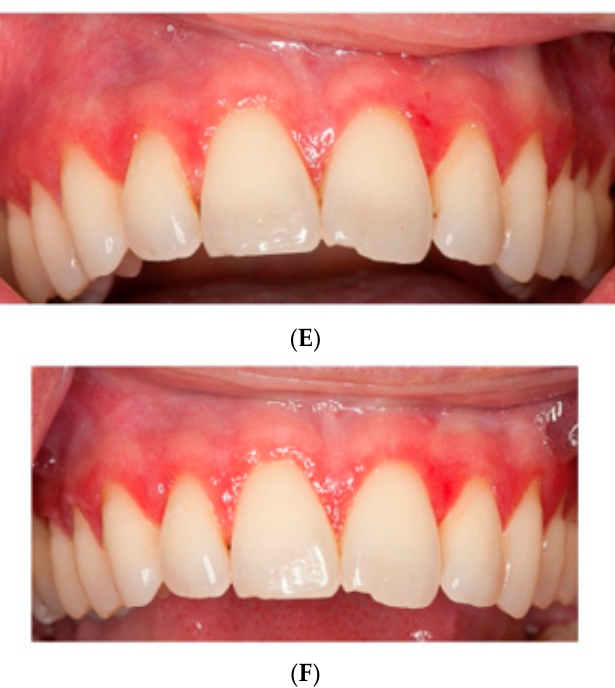
Figure 2. Pictures of patients one and two at ( A , D ) baseline, ( B , E ) HA treatment, ( C , F ) placebo treatment.